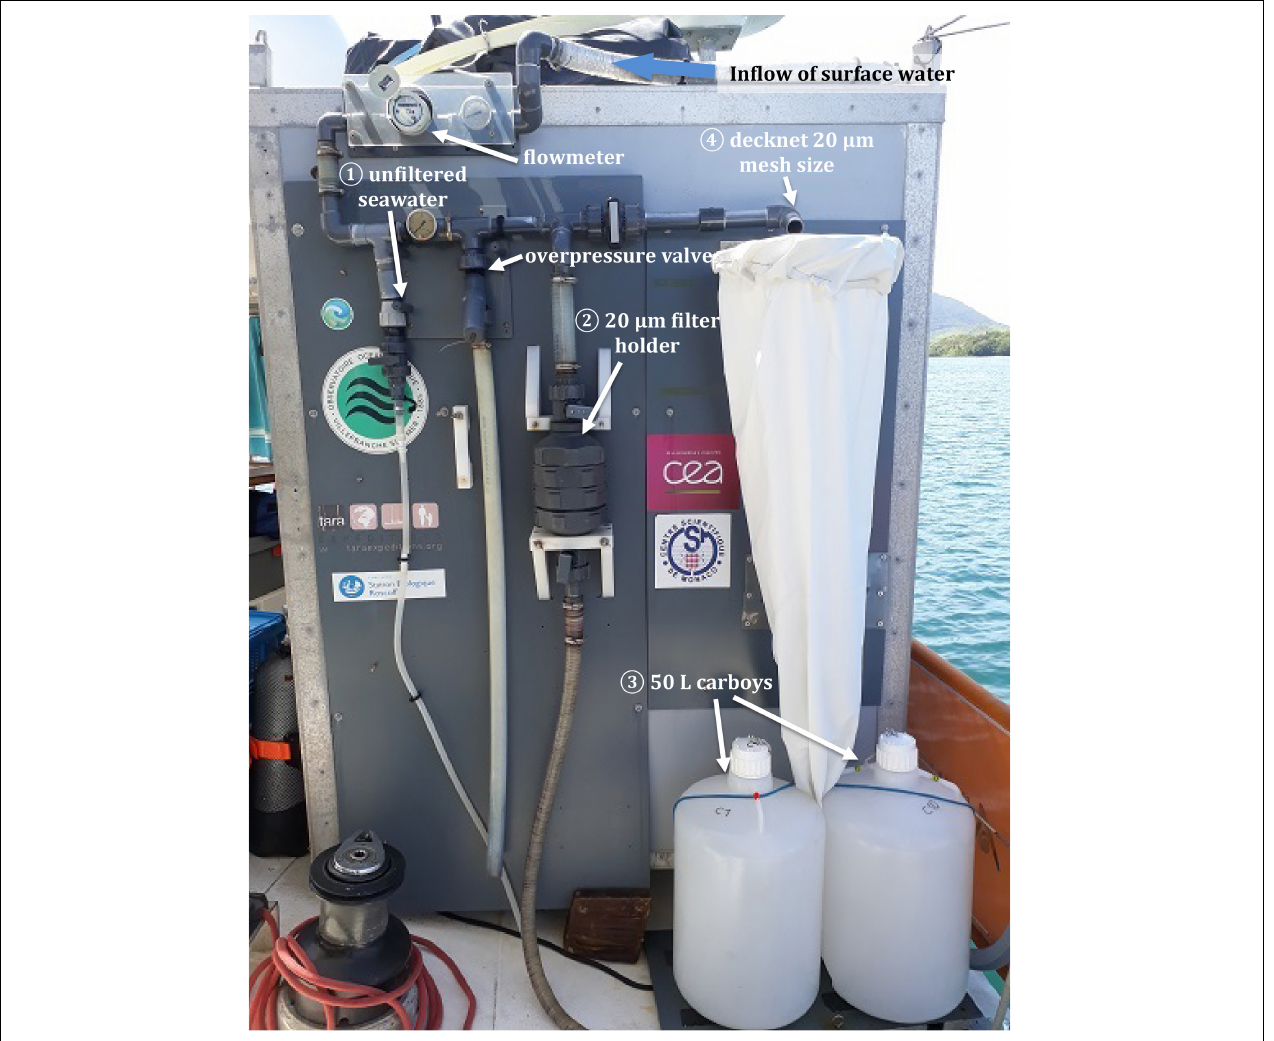
FIGURE 6 | Surface water from the Dolphin was distributed to different outlets installed on the external wall of the wetlab. (1) Unfiltered sea water, used mainly for biogeochemical sampling; (2) pre-filtered seawater on a 20- µ m-pore-size filter mounted inside a 142 mm diameter filter holder; (3) 50 L carboys for the collection